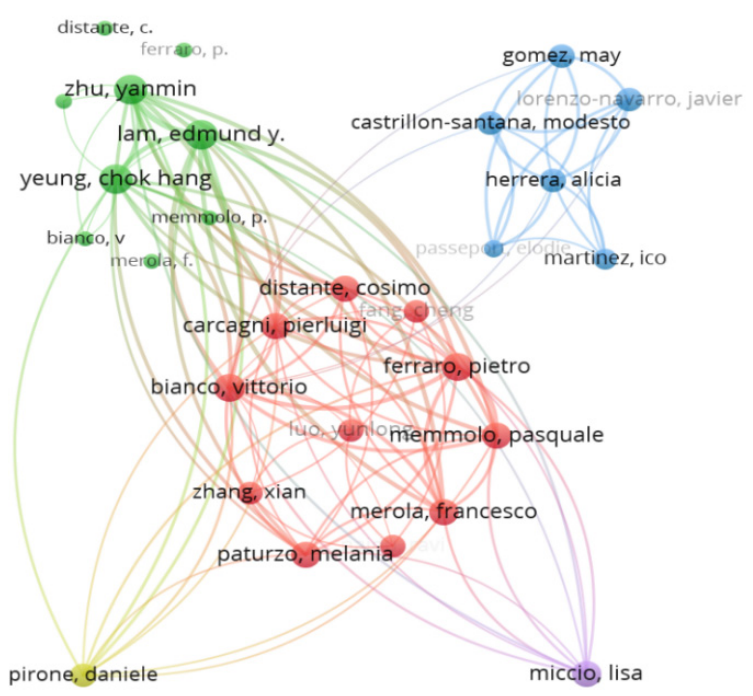
Figure 14. Cited author network structure (Threshold = 2) (visualized with VOSviewer).